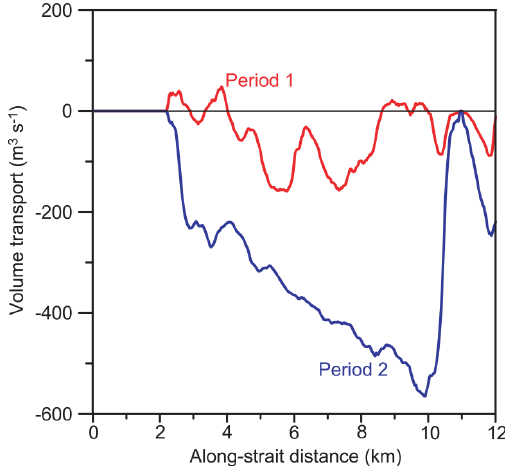
Figure 9. Northward volume transport through (east–west) cross sections below sill depth of the northern sill (from 12m, down- wards) for the two different periods indicated in Fig.